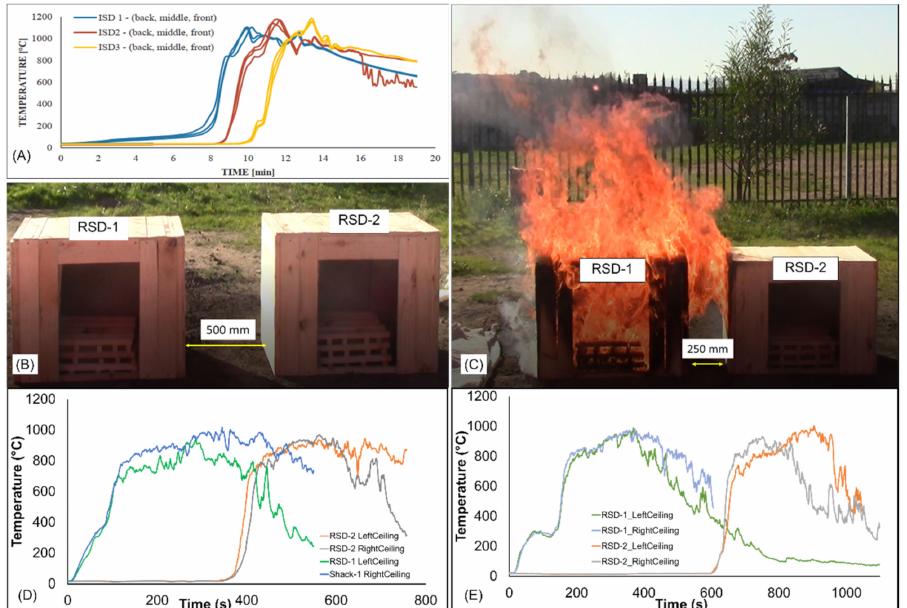
Figure 7. Results from various muti dwelling tests. Clockwise—( A ) FSE results on timber-clad dwelling [7], ( B ) test 6: RSEs on timber-clad dwellings at 500 mm, ( C ) test 5: RSEs on timber-clad dwellings at 250 mm, ( D ) test 6: ceiling temperature in timber-clad dwelling placed at 500 mm, ( E ) test 5: ceiling temperature in timber-clad dwelling placed at 250 mm.